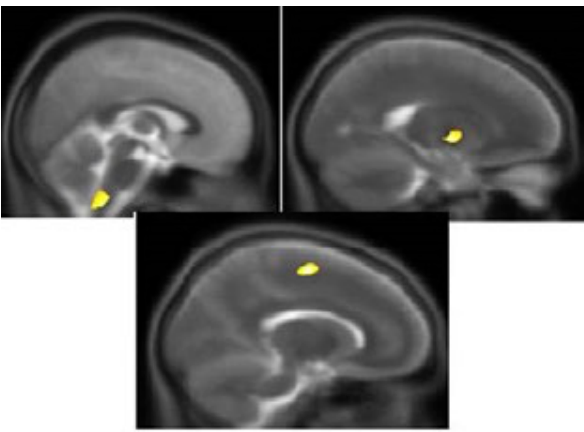
Figure 9. Grey Matter differences in “SOHAM” meditators and non-meditators: Three distinct regions show higher grey matter concentration in meditators. Left Image: Brain stem - Regulates breathing and anxiety level. Right Image:Ventral palladium- Regu- lates positive mood and motivation. Bottom Bottom:Motor area - Regulates motor aspects.